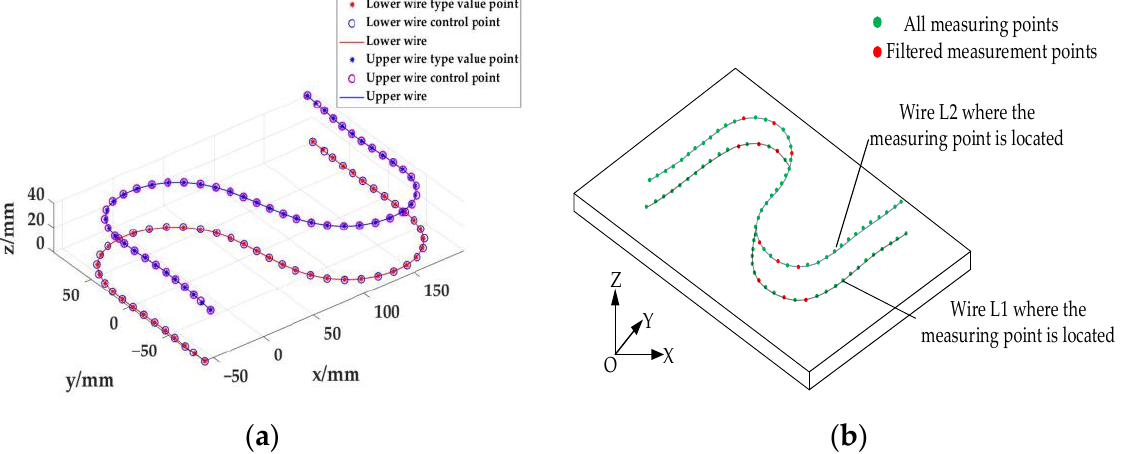
Figure 6. S-shaped specimen model and distribution diagram of measuring points for ( a ) Upper and lower wire models of S-shaped specimens and ( b ) Sampling point distribution diagram of S-shaped specimens.